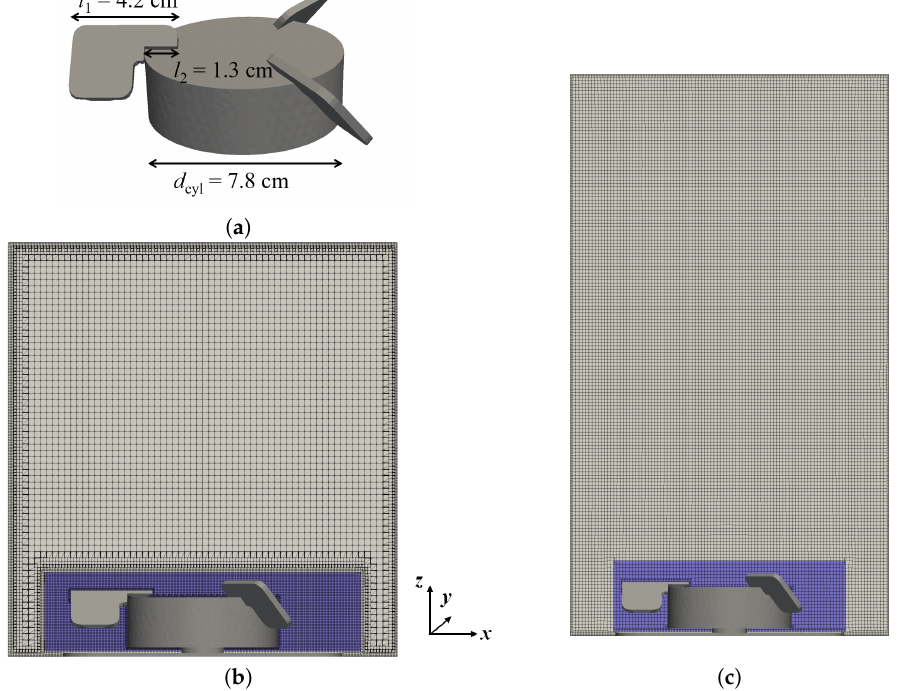
Figure 1. ( a ) Impeller dimensions. ( b ) Vertical cut of the Euler–Lagrange grid. ( c ) Vertical cut of the Euler–Euler grid. The blue areas show the regions to which the rotating reference frame is